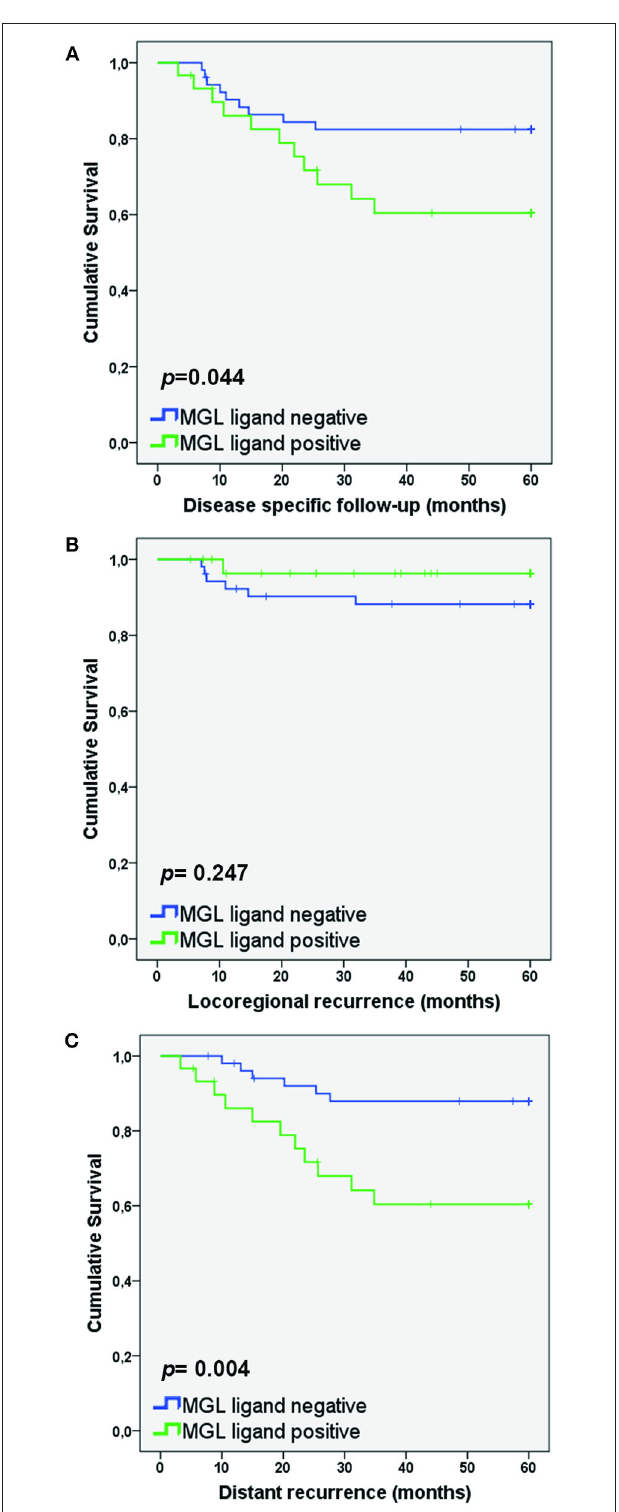
FIGURE 2 | MGL ligand expression correlates to lower survival in patients with distant recurrence. Kaplan Meier survival curves were plotted for SCC/AC patients for Disease-specific survival (A) , Locoregional recurrence (B) , and Distant recurrence (C) . P- values determined by Log rank